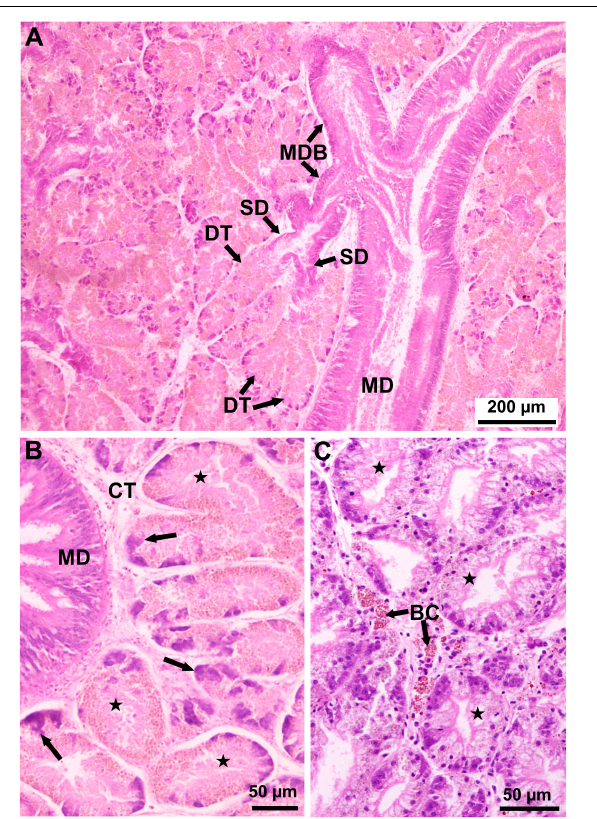
FIGURE 4 | Light micrographs of histological sections stained with MHE showing the normal (healthy) structure of the Pinna nobilis digestive gland. (A) Lower magnification showing a main duct (MD) leading to main duct branches (MDB) from which primary ducts (PD) arise leading to secondary ducts (SD) ending in blind digestive tubules (DT) (Cabrera, May 2011). (B) Higher magnification showing digestive gland tubules (stars) in absorptive phase surrounding a stomach branch (SB); the digestive tubules show highly reduced lumen and tall epithelium, consisting of acidophilic absorptive cells and basophilic young, differentiating cells (arrows); CT, connective tissue (Cabrera, May 2011). (C) Higher magnification showing digestive gland tubules (stars) in holding phase, in which digestive tubules show larger lumen; some brown cells (BC) occur in the connective tissue (Cabrera, March